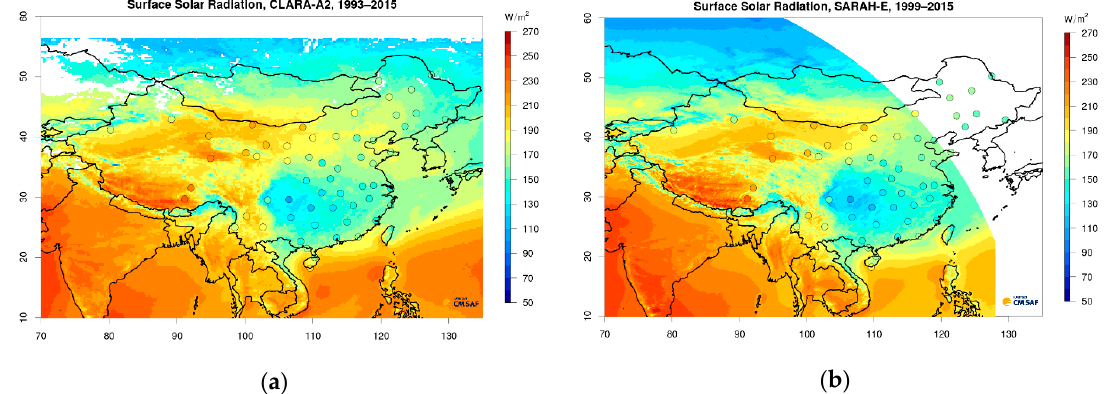
Figure 1. Climatology of multi-year means of satellite-derived surface solar radiation (W m − 2 ) from CLARA-A2 ( a ) for 1993–2015 and SARAH-E ( b ) for 1999–2015 in comparison to surface observations from CMA (denoted by points) for the common periods.